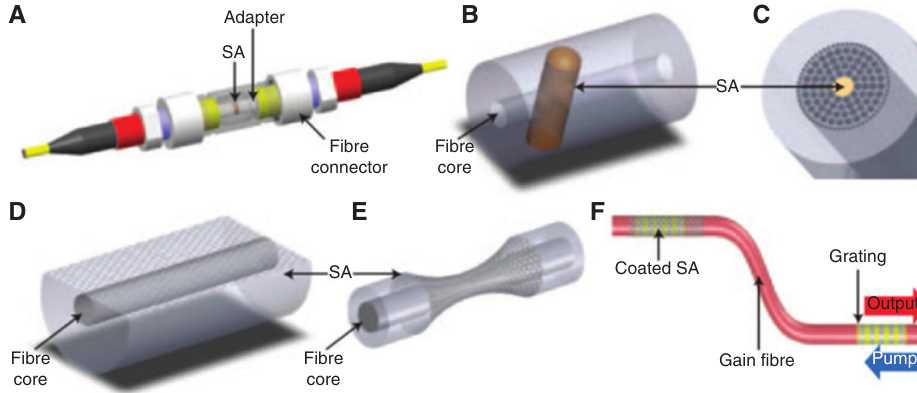
Figure 4: Various CNT SA for the fiber lasers. (A) Sandwiched device, (B) in-fiber microfluidic channels, (C) photonic-crystal fibers, (D) D-shaped and (E) tapered fibers. (F), Fully integrated monolithic fiber laser. Martinez and Sun [76] © Macmillan Publishers Limited